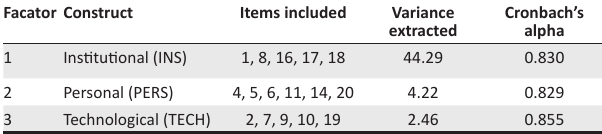
TABLE 3: Academic e-advising challenges. Facator Construct